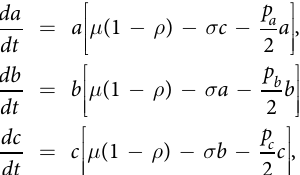
Figure 2 illustrates the possible coexistence states in the RPS system, where the middle column represents a state in which two species coexist - a previously unknown coexist- ence state. Specifically, a stability analysis of the corresponding ODE system with respect to systematic changes in a intraspecific competition parameter, say p a , with fixed p b = 1 and p c = 0.5, reveals the following